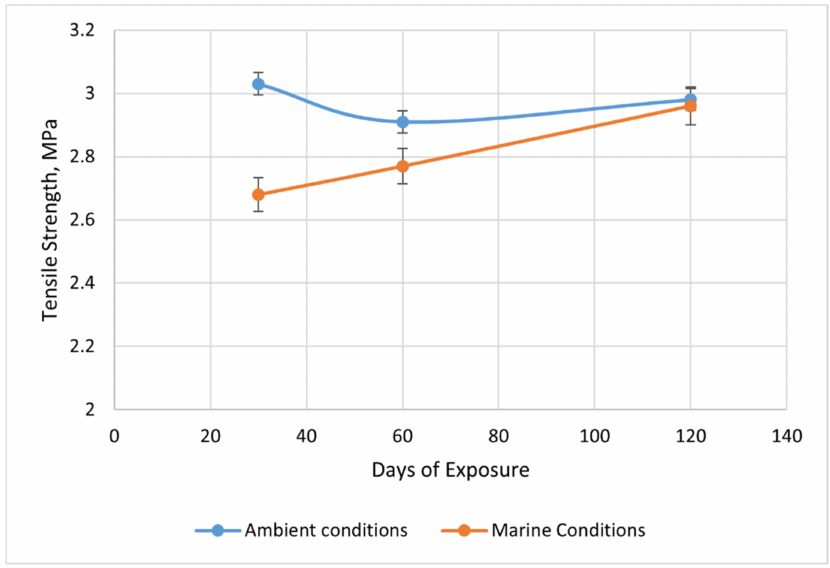
Figure 8. Indirect tensile strength of ambient and marine exposed